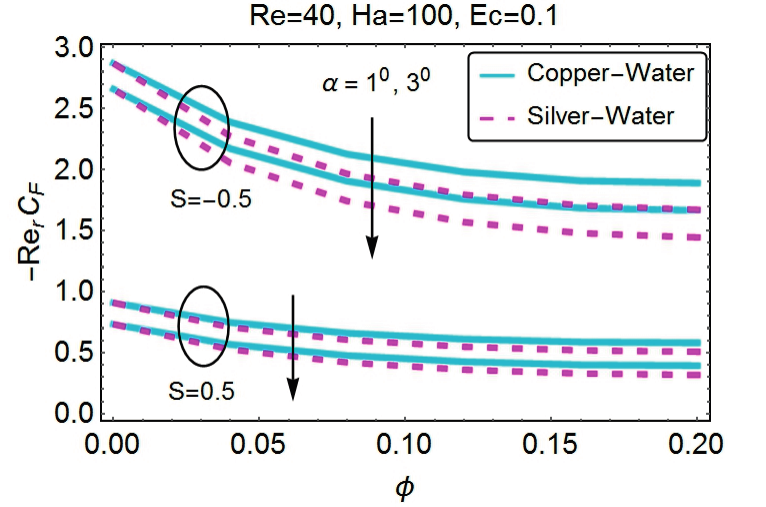
Figure 28. Variation in the skin friction coefficient with the angle and the nanoparticle volume fraction (divergent channel).